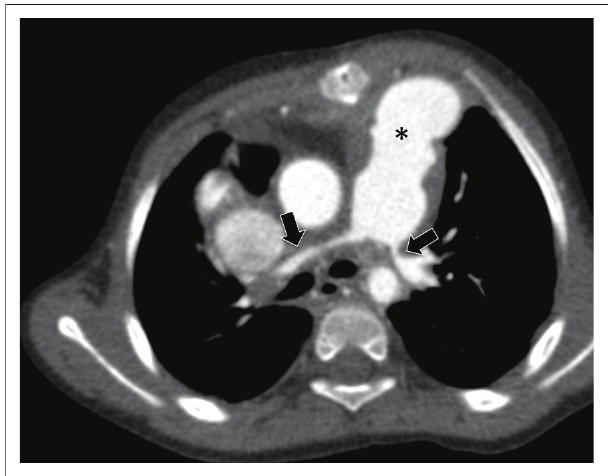
FIGURE 14: Thirty-three-month-old girl with a RVOT aneurysm post repair. Axial CT demonstrates a large post-surgical aneurysm of the transannular patch (asterisk) and worsening stenosis of both pulmonary arteries at their origins